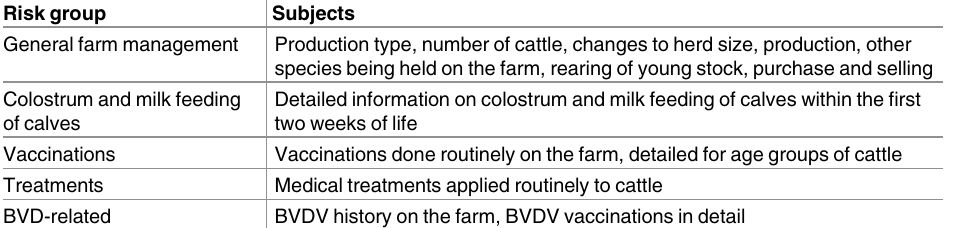
Table 1. Risk factor groups included in study questionnaire of multi-country BNP case-control